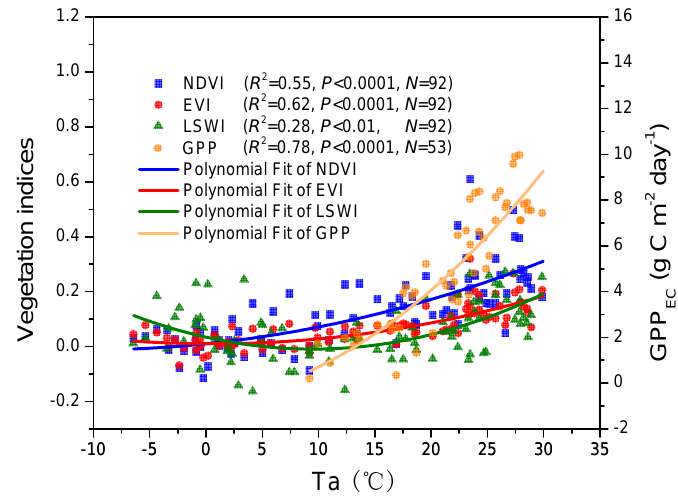
Figure 6. Linear relationships between ( a ) Normalized Difference Vegetation Index (NDVI); ( b ) Enhanced Vegetation Index (EVI); ( c ) Land Surface Water Index (LSWI); and ( d ) estimated GPP from EC tower data (GPP EC ) and air temperature (Ta) during 2009–2010. NDVI = 0.00019·Ta 2 + 0.004·Ta + 0.01 ( R 2 = 0.55, p < 0.0001, N = 92); EVI = 0.0002·Ta 2 − 0.0002·Ta + 0.01 ( R 2 = 0.62, p < 0.0001, N = 92); LSWI = 0.00048·Ta 2 − 0.0092·Ta + 0.034 ( R 2 = 0.28, p < 0.0001, N = 92); GPP EC = 0.009·Ta 2 + 0.053·Ta − 0.76 ( R 2 = 0.78, p < 0.0001, N = 53).